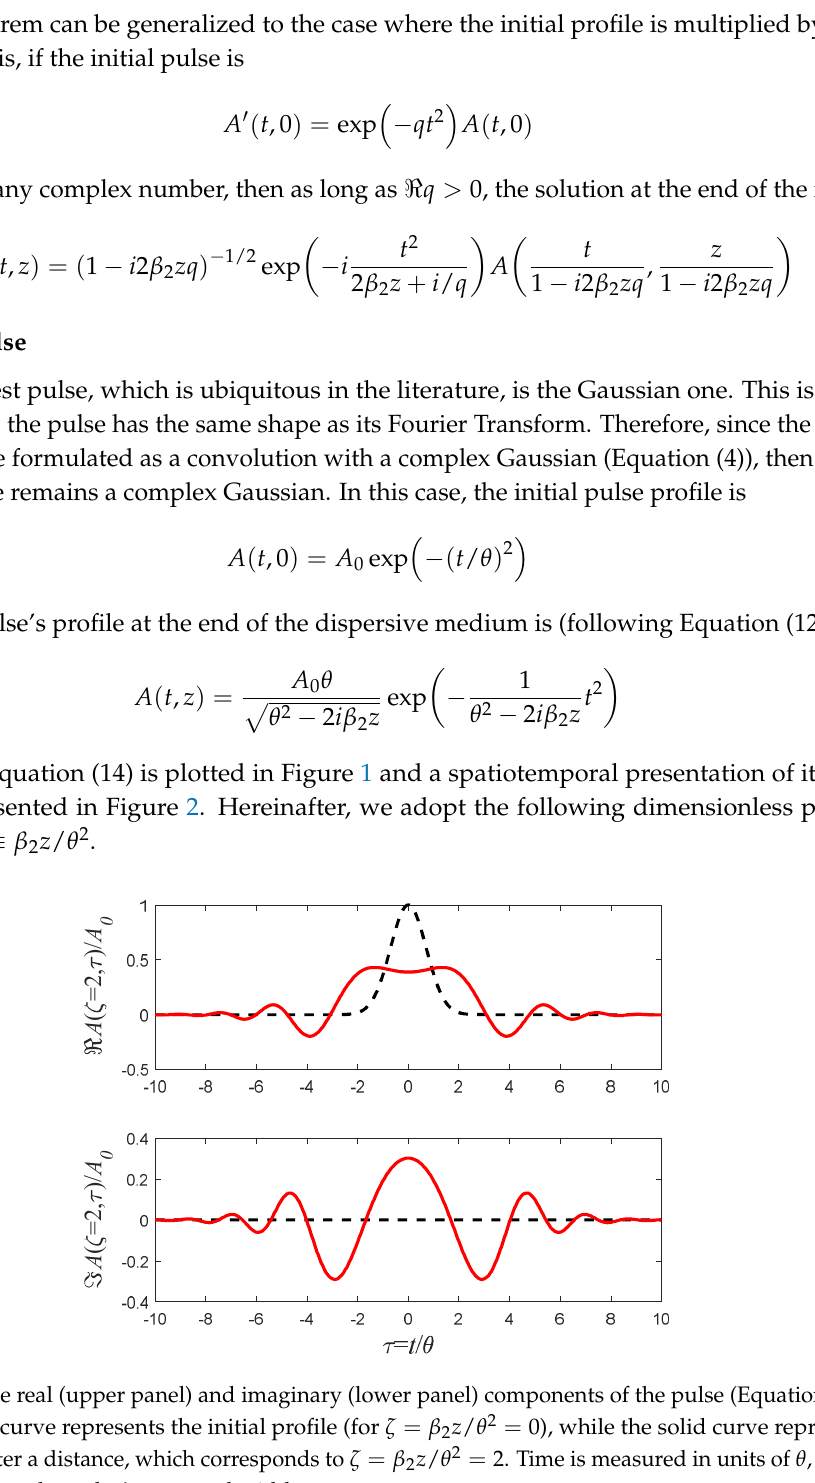
Figure 2. A false-color presentation of the pulse's intensity